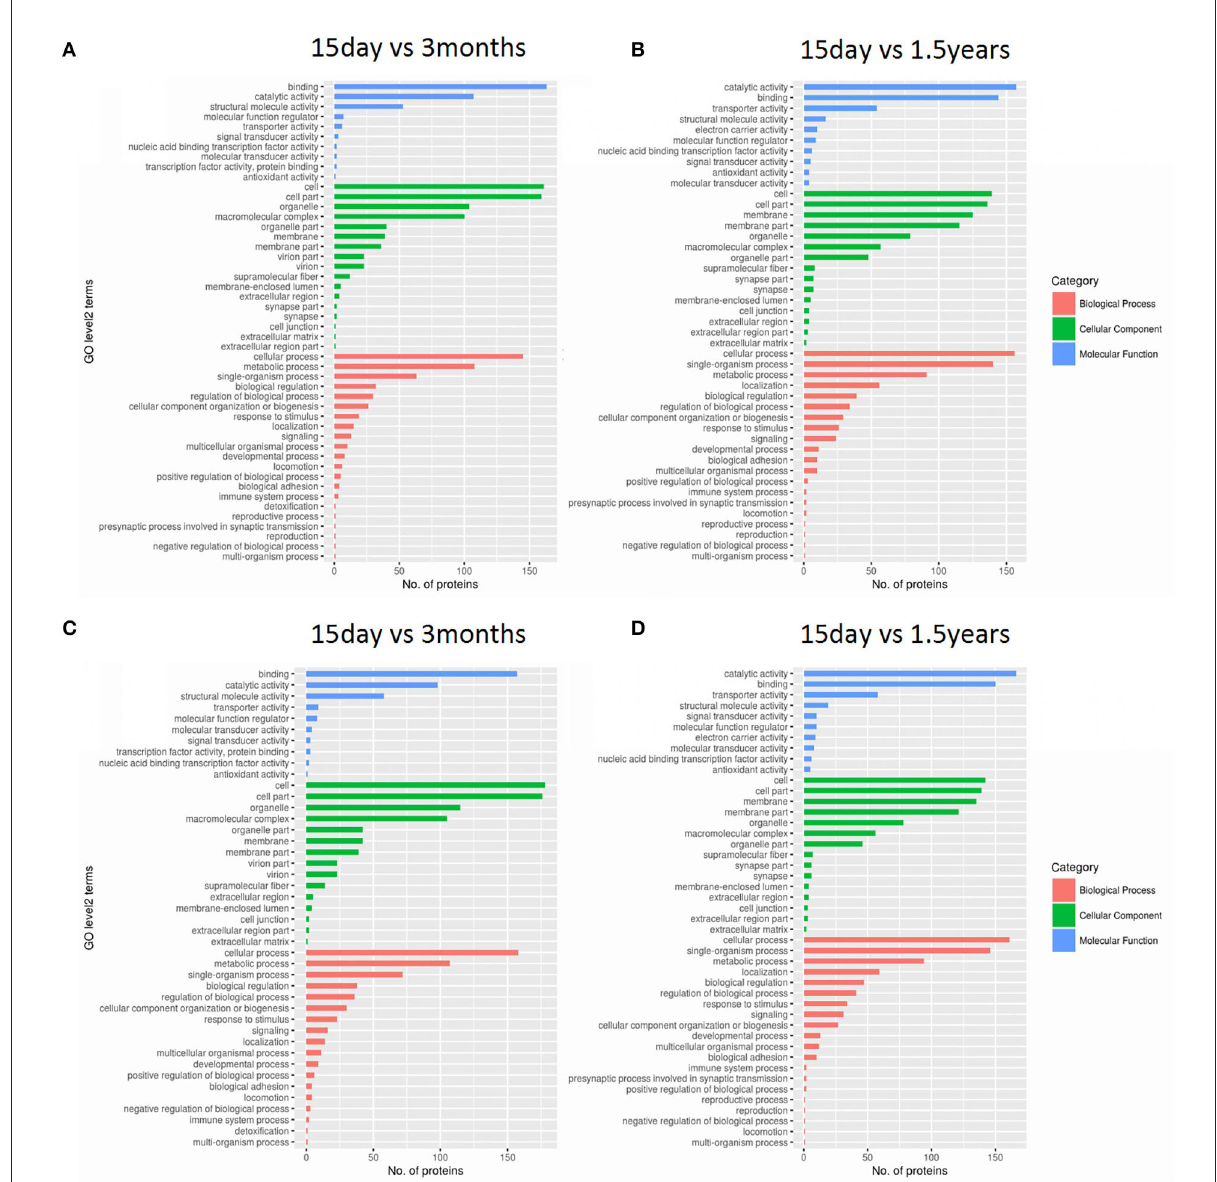
FIGURE2 Gene ontology (GO) functional analysis of differentially expressed proteins. Enrichment classification at the second level of GO analysis. The length of the histogram indicates the number of functionally rich proteins, the red stripe represents biological processes, the green stripe represents cellular components, and the blue stripe represents molecular functions. (A) The upregulated protein functional enrichment in the 15-day and 1.5-year age groups, (B) the upregulated protein functional enrichment in the 15-day and 3-month age groups, (C) the downregulated protein functional enrichment in the 15-day and 1.5-year age groups, and (D) the downregulated protein functional enrichment in the 15-day and 3-month age groups.